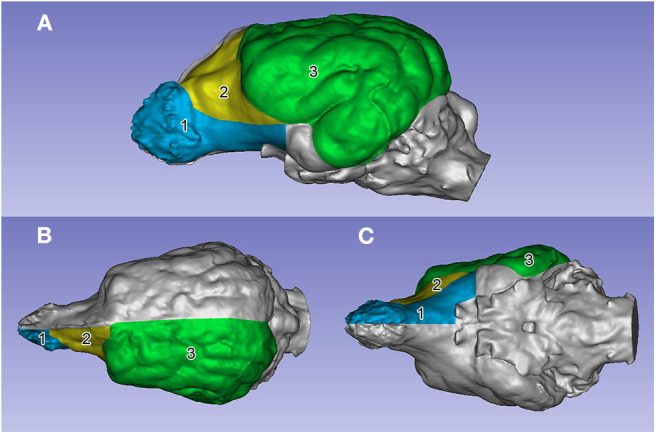
The segmented surface regions on the left side on an English setter's endocast. (A) Left lateral view. (B) Dorsal view. (C) Ventral view. (1) Prepiriform rhinencephalic area (in blue). (2) Prefrontal area (in yellow). (3) Non-prefrontal cerebral convexity area (in green).